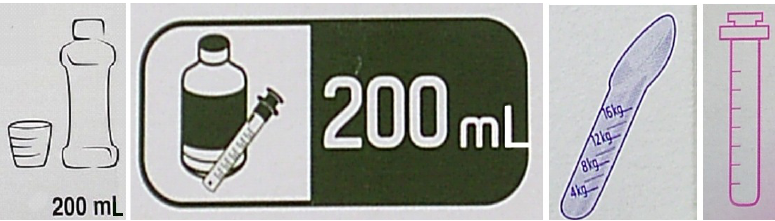
Figure 3. Pictograms showing products.